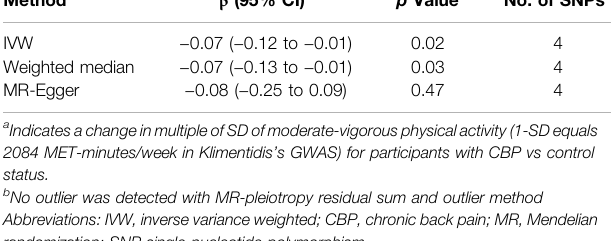
TABLE 3 | MR results for the effect of chronic back pain (CBP) on self-reported moderate-vigorous physical activity.